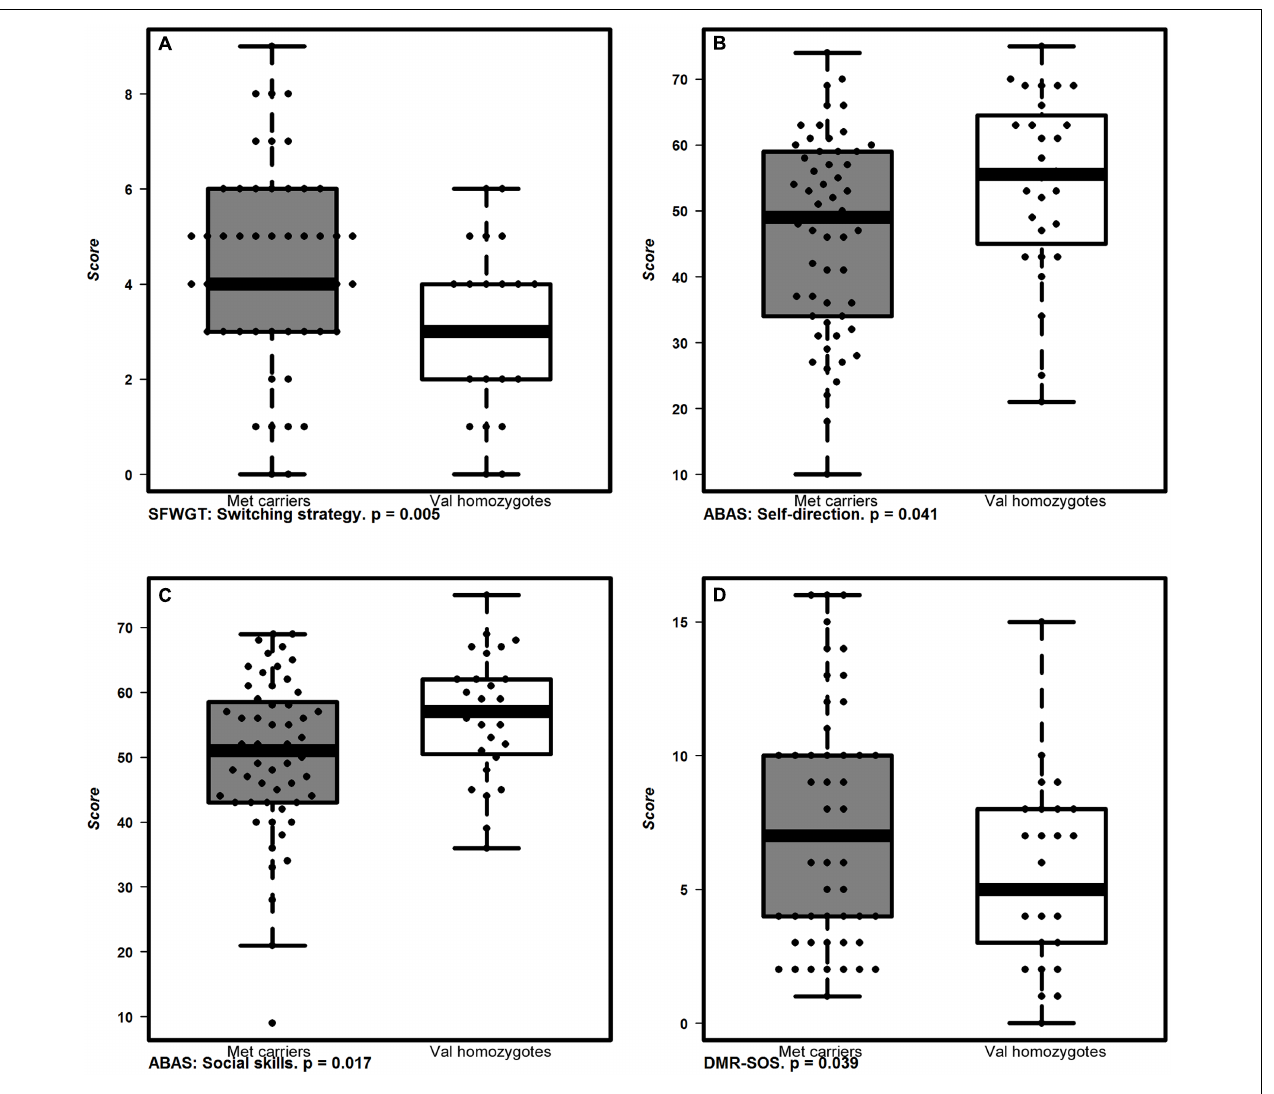
FIGURE 2 | Cognitive and functional performance associated to COMTVal158Met polymorphisms. Box plots represent the behavioral and cognitive performance of allelic groups of COMTVal158Met polymorphism. Met carriers (gray boxes) performed better in mental flexibility measured by (A) SFWGT (Switching strategy; p < 0.005; two way ANOVA) and had worse parental reports in two ABAS-II subscales: (B) ABAS-Self-Direction ( p < 0.041; two way ANOVA) and (C) ABAS-Social Skills ( p < 0.017; two way ANOVA), and also in the (D) social scale of the DMR; DMR-SOS ( p < 0.039; two way ANOVA) than Val homozygotes (white boxes). The boxplots show the median as well as the interquartile range. Dots indicate individual